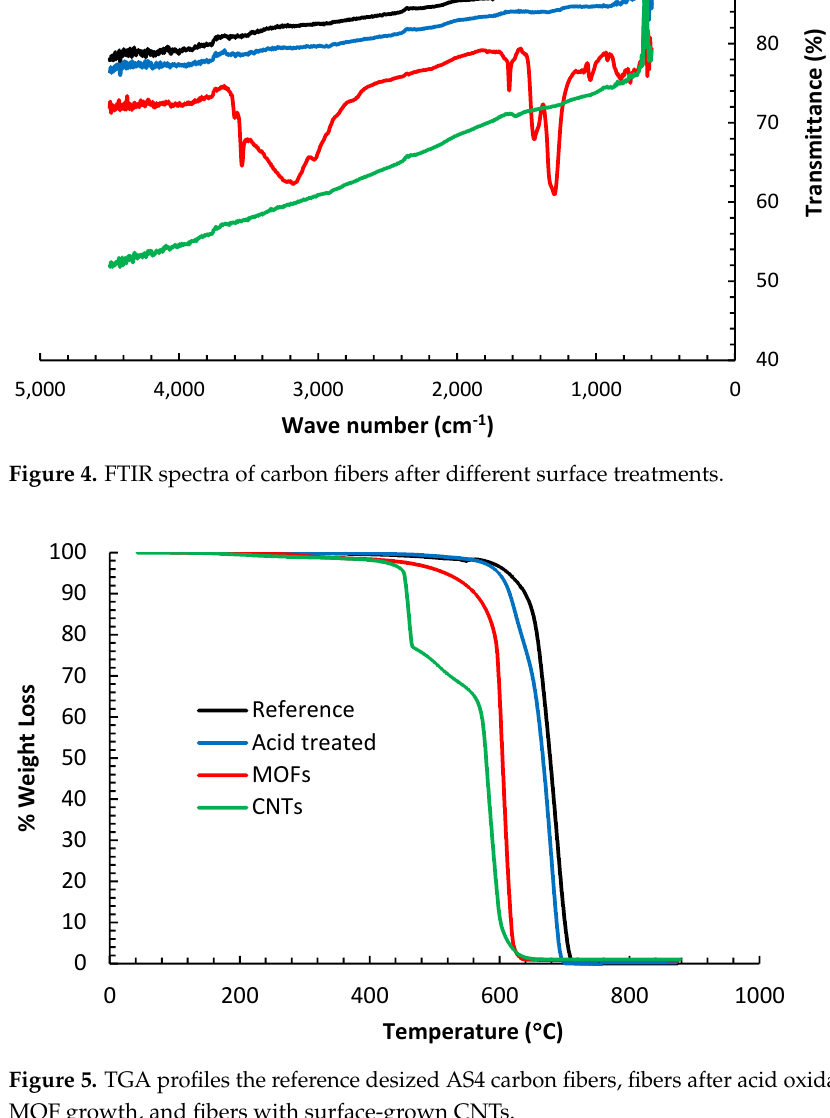
Figure 5. TGA profiles the reference desized AS4 carbon fibers, fibers after acid oxidation, fibers with MOF growth, and fibers with surface-grown CNTs.